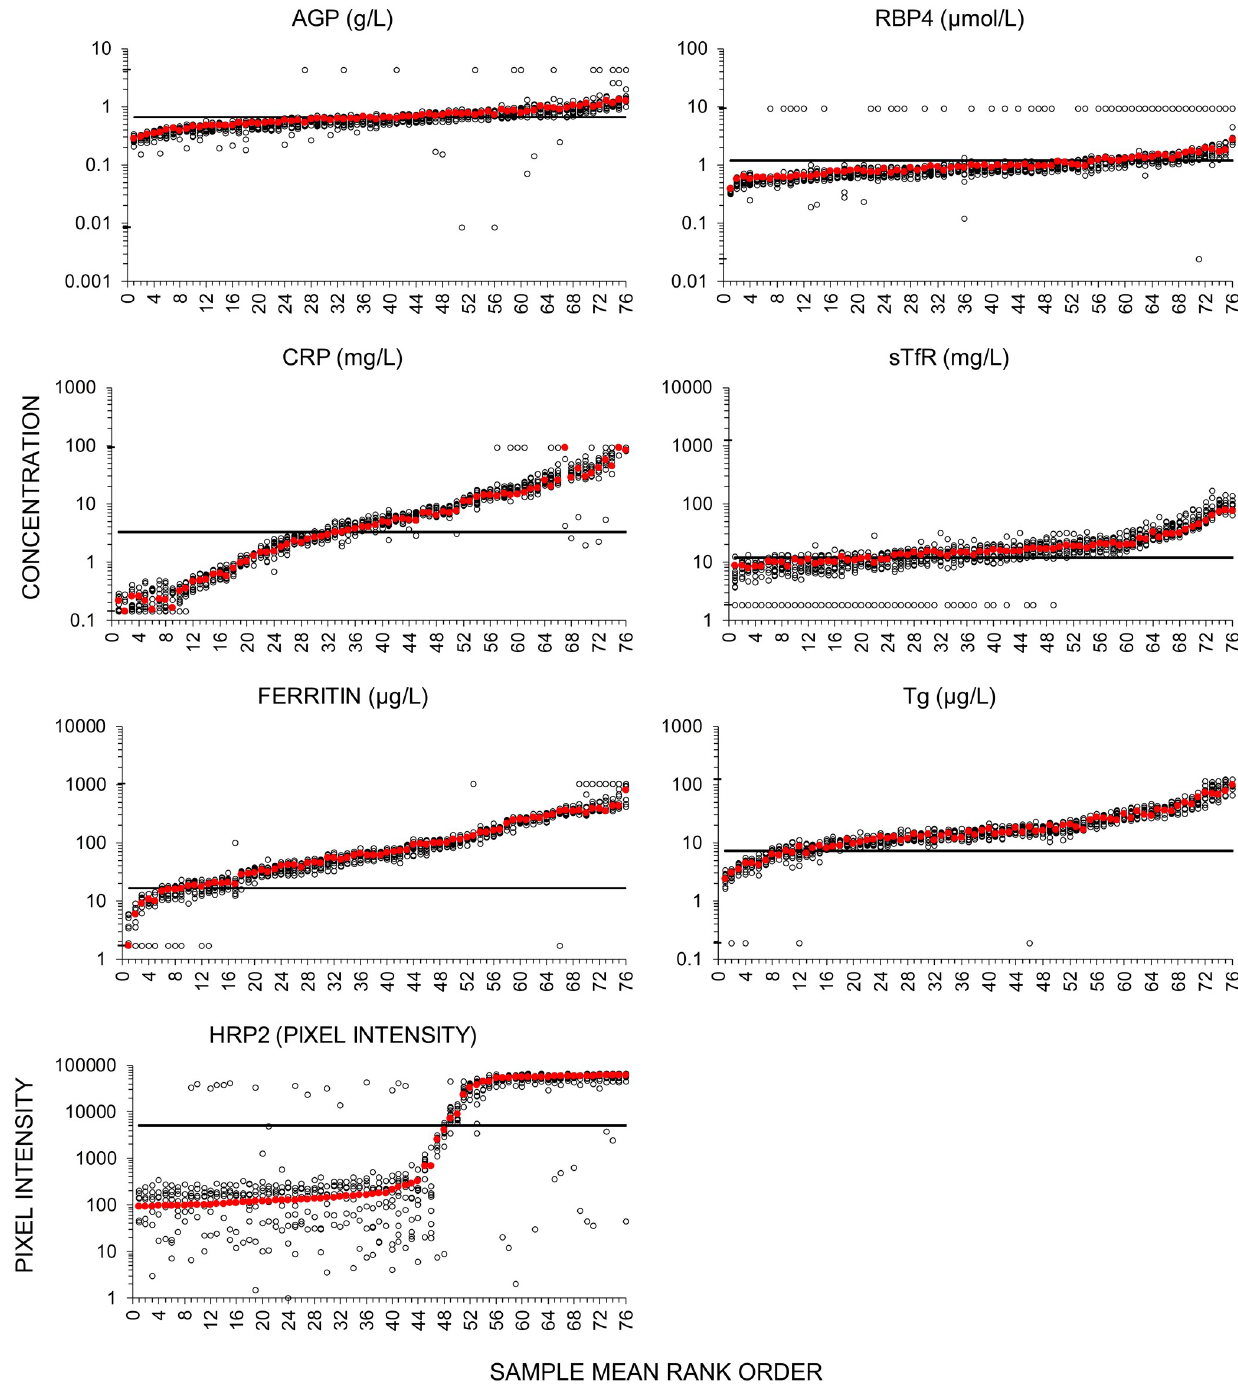
Fig 2. Repeated measures across laboratories for a panel of 76 plasma specimens. Open circles measured mean concentration (or pixel intensity for HRP2) of duplicate wells from a single plate. Red closed circles, mean concentration, duplicate wells run on each of 3 plates (2 PATH, 1 UW) for every sample. Results are plotted on Log10 Y axes to reveal proportional differences at lower concentrations and have been sorted by rank order of the mean concentration from 3 plates (2 PATH, 1 UW). Horizontal line, optimal 7-plex cutoff value; for HRP2, line represents approximate pixel intensity corresponding to the cutoff concentration. Cutoff values were determined by ROC curve analysis using results from the NiMaNu study as a gold-standard, and using the cutoff thresholds applied in that study [23]. Black hash marks on y-axes indicate lot-specific upper- and lower-limits of quantification (see S4 Table); values have been adjusted to account for 1:10 sample dilution used for all samples. Results out of range are plotted as the limits values noted in S4 Table. AGP, α -1-acid glycoprotein; CRP, C-reactive protein; HRP2, histidine rich protein 2; RBP4, retinol binding protein 4; sTfR, soluble transferrin receptor; Tg,